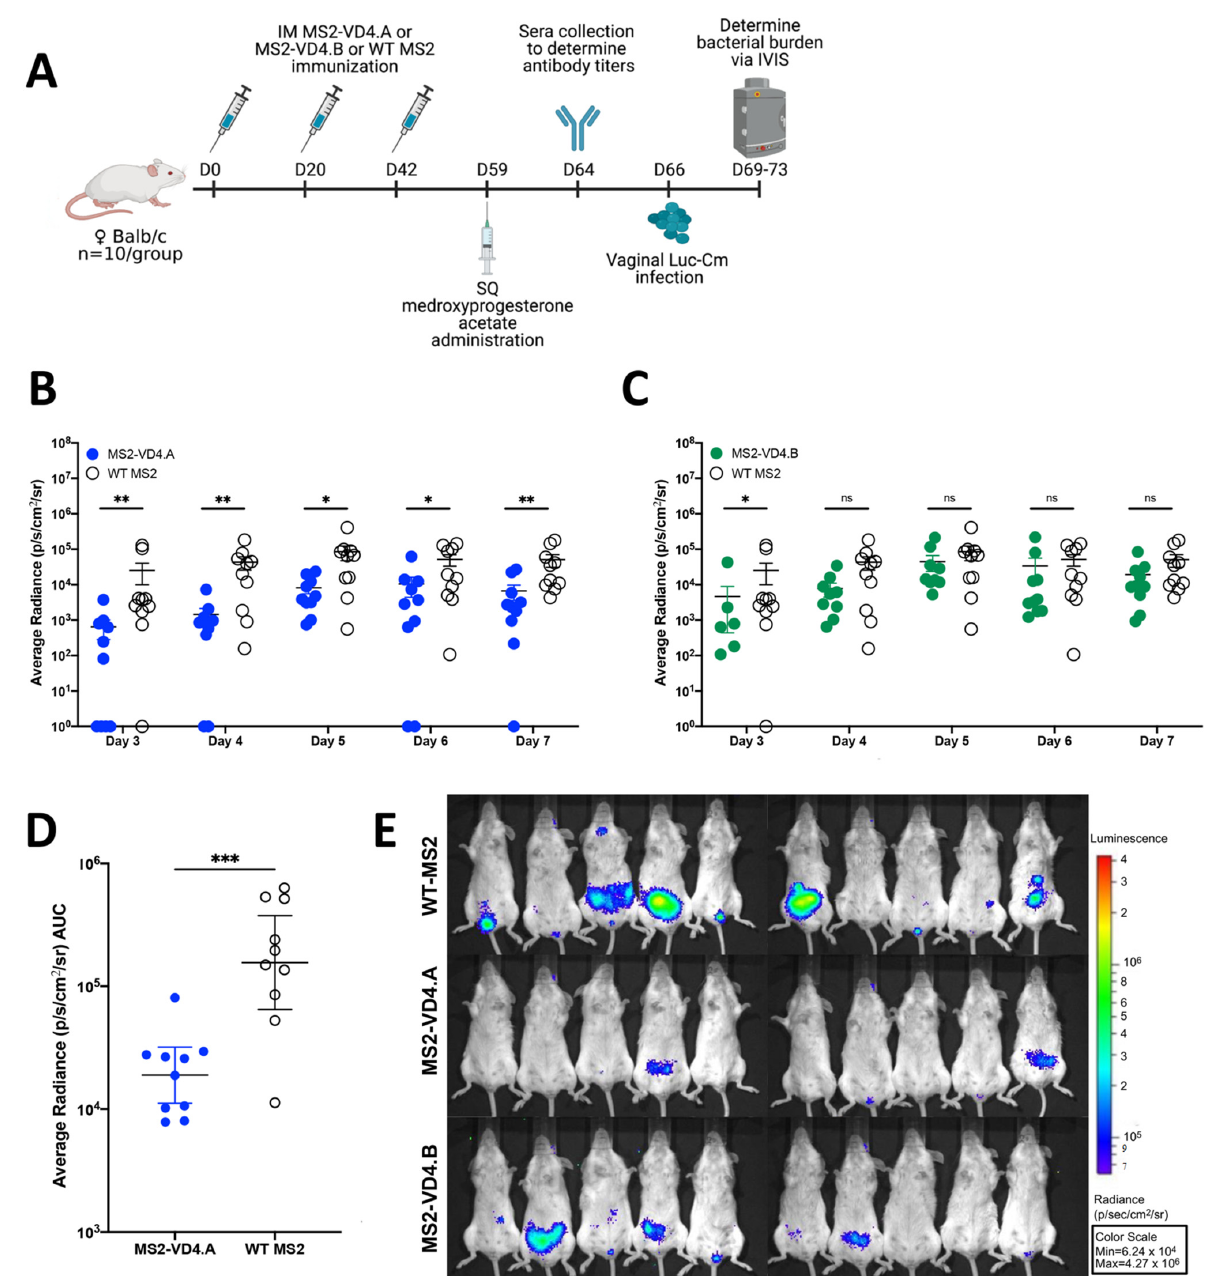
Figure 7. Immunization with MS2-VD4.A results in decreased urogenital Chlamydia burden as compared to WT MS2 immunized controls. ( A ) Immunization schedule. Female Balb/c mice ( n = 10/group) were immunized three times, 3 weeks apart with their respective vaccine. Mice were administered 2.5 mg of Depo-Provera before vaginal challenge with Luc-Cm. ( B ) Average radiance (p/s/cm 2 /sr) measured for MS2-VD4.A and WT MS2 on days 3 through 7 post infection. ( C ) Average radiance (p/s/cm 2 /sr) measured for MS2-VD4.B and WT MS2 on days 3 through 7 post infection. ( D ) Area under the curve (AUC) measured for average radiance on days 3 through 7 post infection for MS2-VD4.A and WT MS2. ( E ) IVIS images for WT MS2 control mice (top), MS2-VD4.A mice (middle), and MS2-VD4.B mice (bottom) on day 7 post infection, with luminescence visualized, shown as a representative image of those collected each day. Statistical analysis was performed utilizing the nonparametric Mann–Whitney t -test. Quantitative data represent the geometric mean ± SEM. * p < 0.05, ** p < 0.01, *** p <